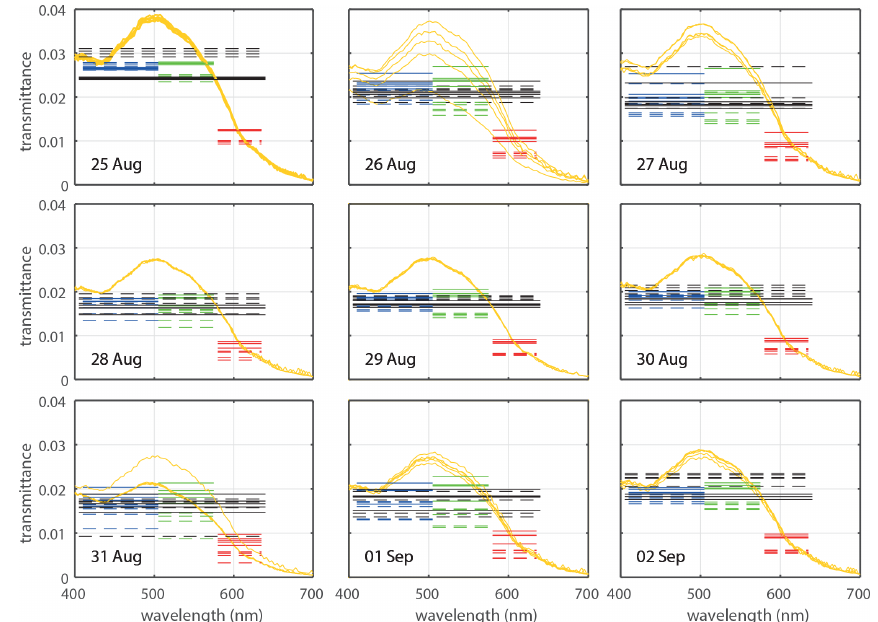
Figure 11. Spectral transmittance data of the five measurements centered around solar noon during 9d of the deployment: transmittance spectra measured by the TriOS RAMSES radiometers (yellow) are overlain by horizontal lines for the four different spectral bands (red, green, blue and clear) reconstructed from TriOS RAMSES spectra (solid lines) and chain measurements (dashed